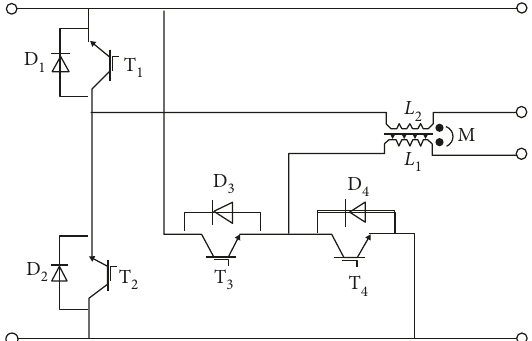
Figure 5: Block diagram of the supercapacitor voltage and current